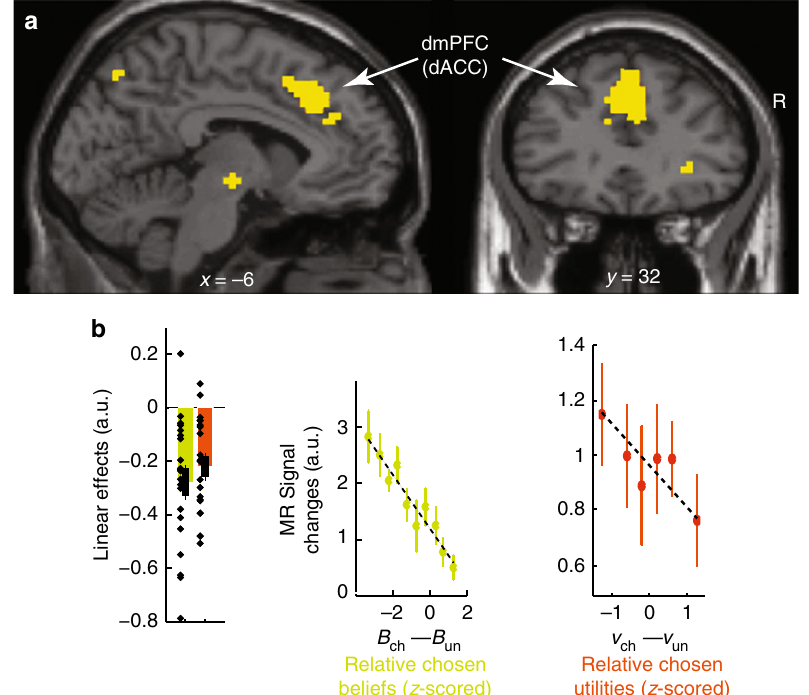
Fig. 5 Prefrontal activations involved in computing choices. a Topography of frontal activations negatively correlated with relative chosen normalised utilities ( v chosen – v unchosen ) and with relative chosen state beliefs ( B chosen – B unchosen ) with no interactions between these factors ( p > 0.05, uncorrected), from model MIX. Activations are thresholded at p < 0.05 (T-tests, voxel-wise corrected for family-wise errors over the frontal lobes: MNI coordinate Y > 0; cluster-wise threshold p < 0.05) and superimposed on sagittal and coronal anatomical slices (MNI template, X = − 6 and Y = 32). Frontal activations are located in the dmPFC. See Supplementary Table 4 for coordinates of activation peaks. b , left: sizes of linear effects (betas) for relative chosen beliefs and normalised utilities (green and orange, resp.) averaged over the dmPFC activation cluster shown in a (leave-one-out procedure removing selection biases). b , right: activations averaged over the dmPFC activation cluster shown in a and plotted against relative chosen beliefs (no quadratic component factored out) and normalised utilities (the quadratic component being factored out is shown in Fig. 7), z -scored within each participant. All error bars are s.e.m. across participants ( N =